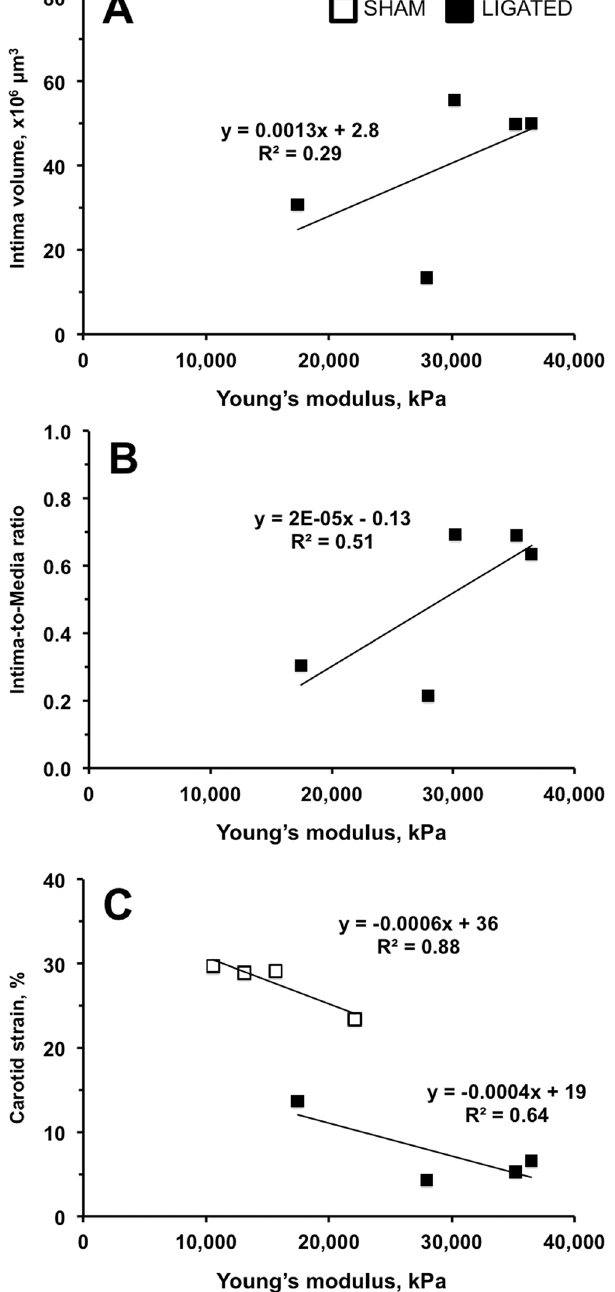
Figure 5. Relationships between the Young’s modulus and the left carotid remodeling in FVB mice after ligation. Open squares are sham-operated animals (SHAM). Black squares are ligated mice (LIGATED). Intima volume ( A ) and Intima/Media Ratio ( B ) positively correlate with the Young’s modulus. It was not possible to measure the intimal layer in non-ligated arteries. ( C ) The carotid strain negatively correlated with the Young’s modulus. n =